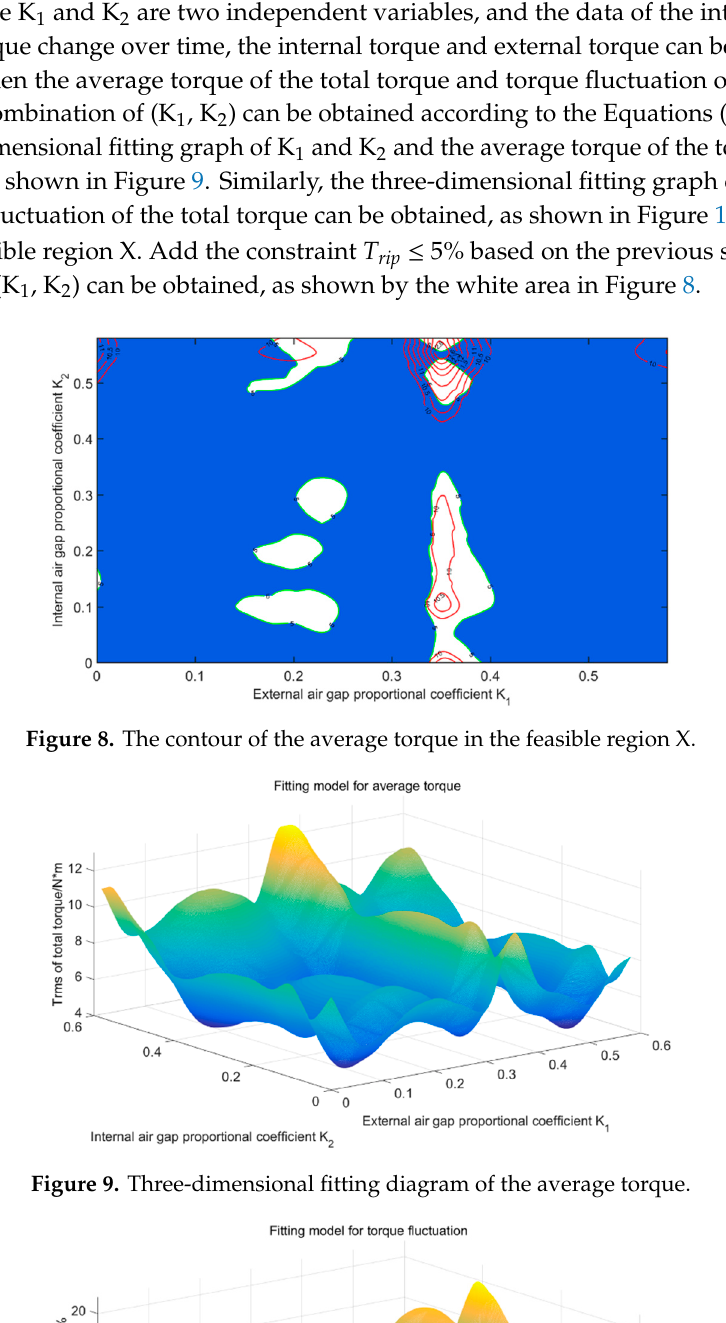
Figure 8. Three-dimensional fitting diagram of the average torque.